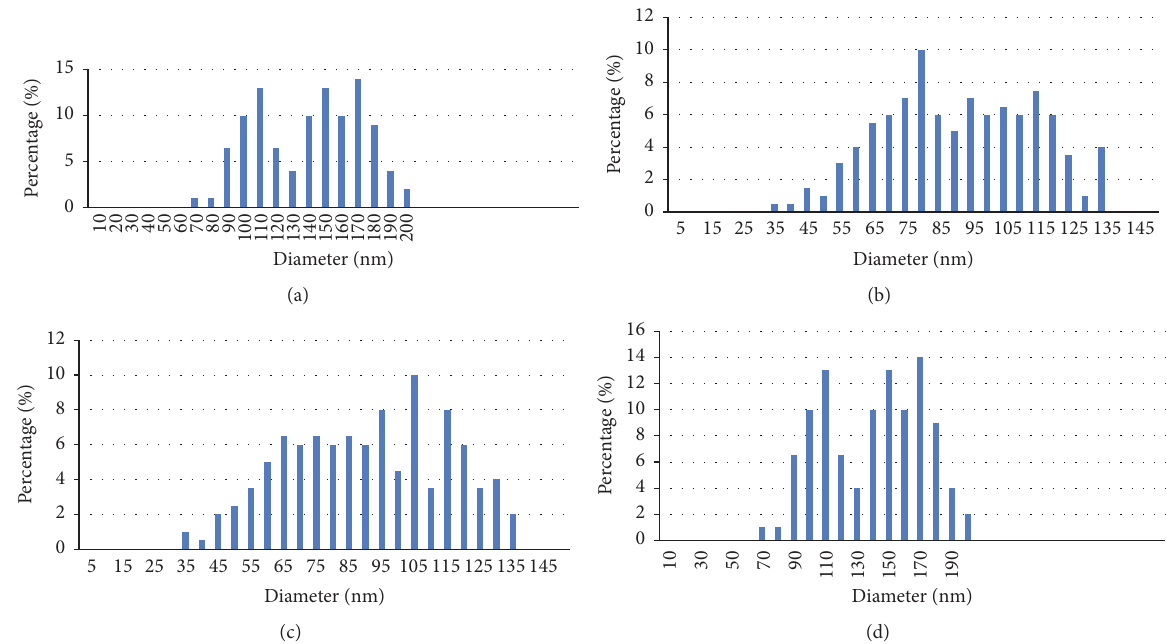
Figure 8: Size distribution for Ag at (a) 700 mJ, (b) 720 mJ, (c) 740 mJ, and (d) 760